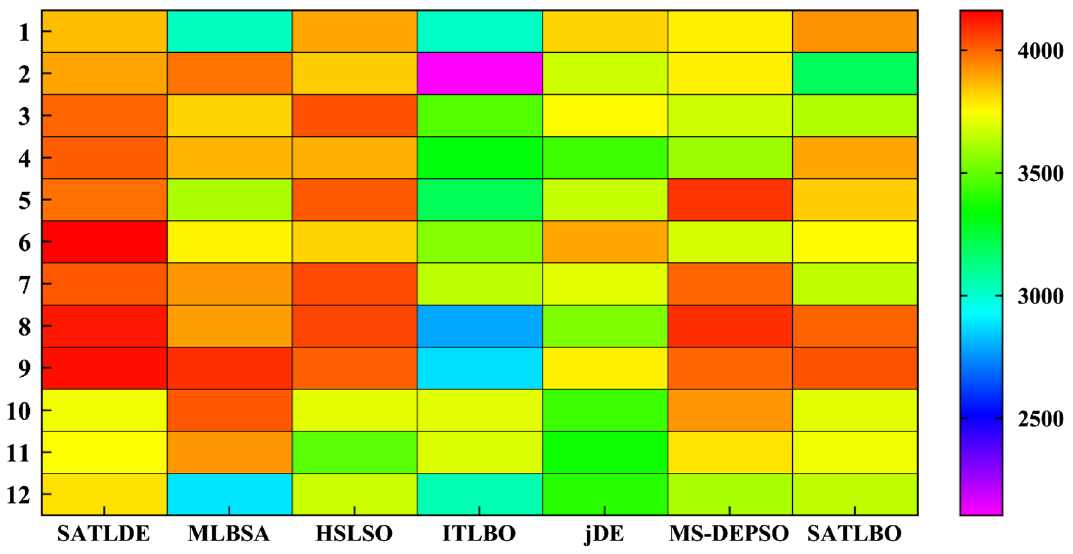
Figure 13. Monthly average of hydropower energy generated by all